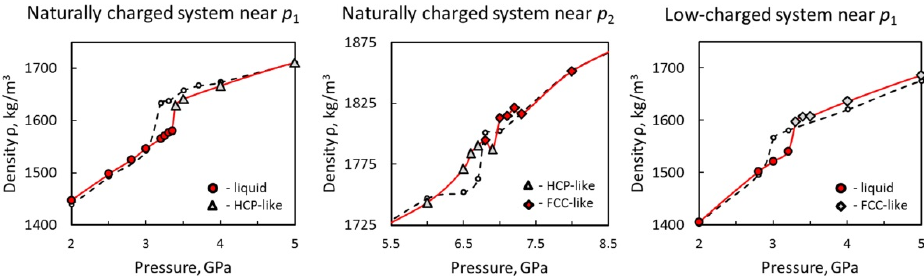
Figure 4. Results of extended (up to 5 ns) simulations for the fourfold-enlarged models of 144[2Me (II) (OH) 2 ·7H 2 O], containing 1008 water molecules, near the phase transformation points. The estimates of confined water density are consistent with the smaller models, but a slight shift of the phase transition points by about +(0.1–0.3) GPa is observed in the enlarged system. According to these results, for the naturally charged system p 1 ~3.3–3.4 GPa and p 2 ~6.7–7.1 GPa, and for the low-charged system p 1 ~3.2–3.3 GPa. Colors: red solid lines for the enlarged system (red circles represent the liquid phase, white triangles represent the HCP-like phase, and red rhombuses represent the FCC-like phase of the naturally charged system; white rhombuses represent the FCC-like phase of the low-charged system); black dashed lines (small circular markers) for the base model.